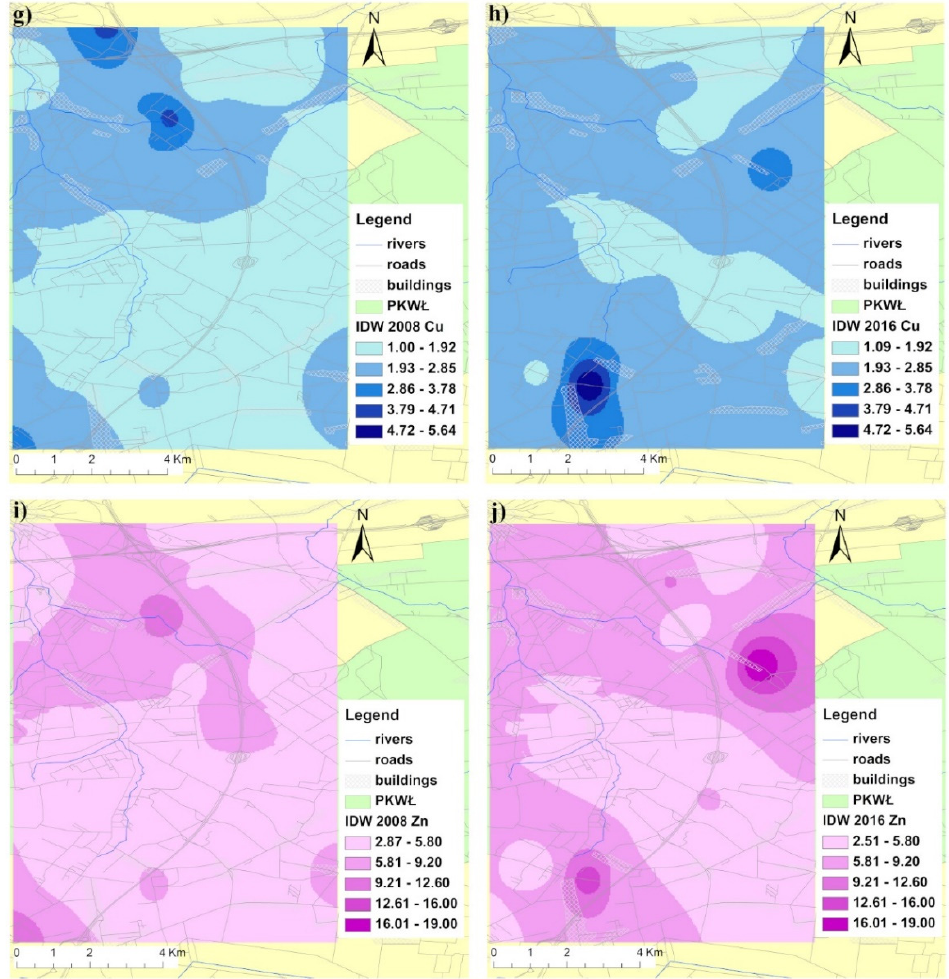
Figure 4. Spatial distribution of metal concentrations [mg/kg]: ( a ) Pb (2008); ( b ) Pb (2016); ( c ) Ni (2008); ( d ) Ni (2016); ( e ) Cd (2008); ( f ) Cd (2016); ( g ) Cu (2008); ( h ) Cu (2016); ( i ) Zn (2008); ( j ) Zn (2016).